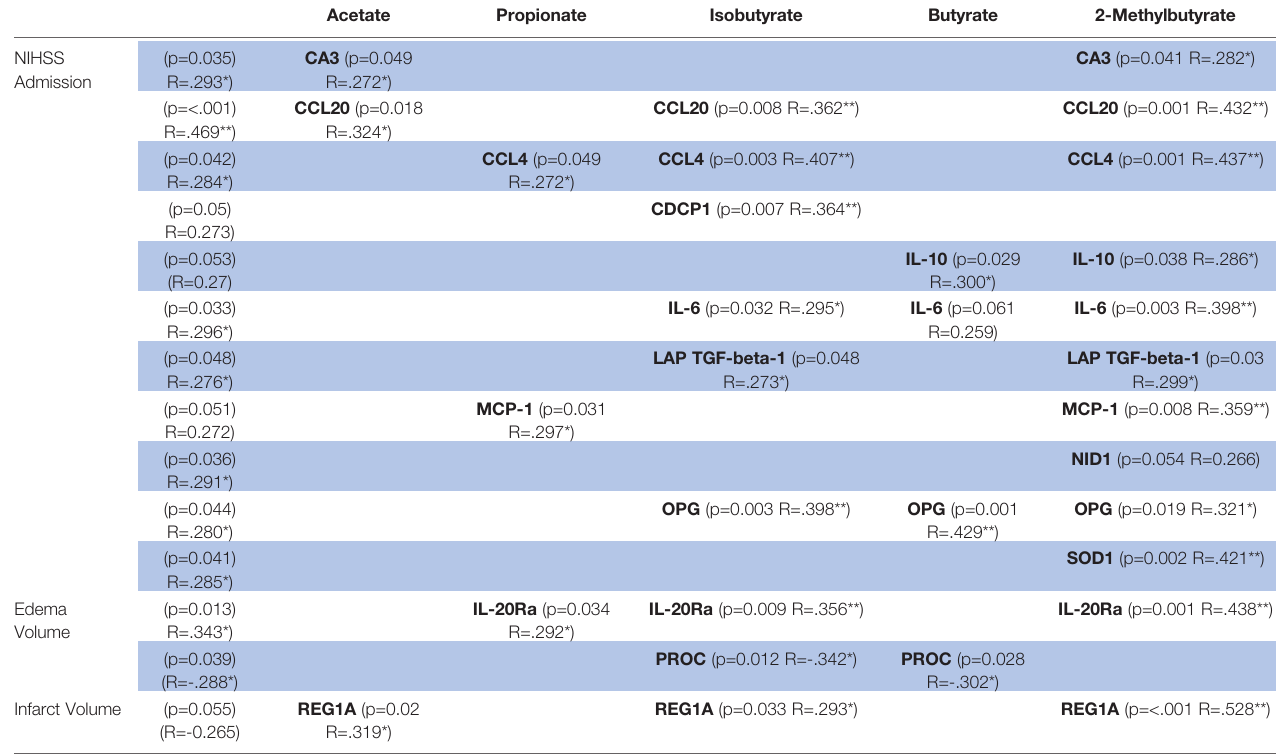
TABLE 5 | Systemic proteins correlated with both SCFAs and stroke presentation parameters.